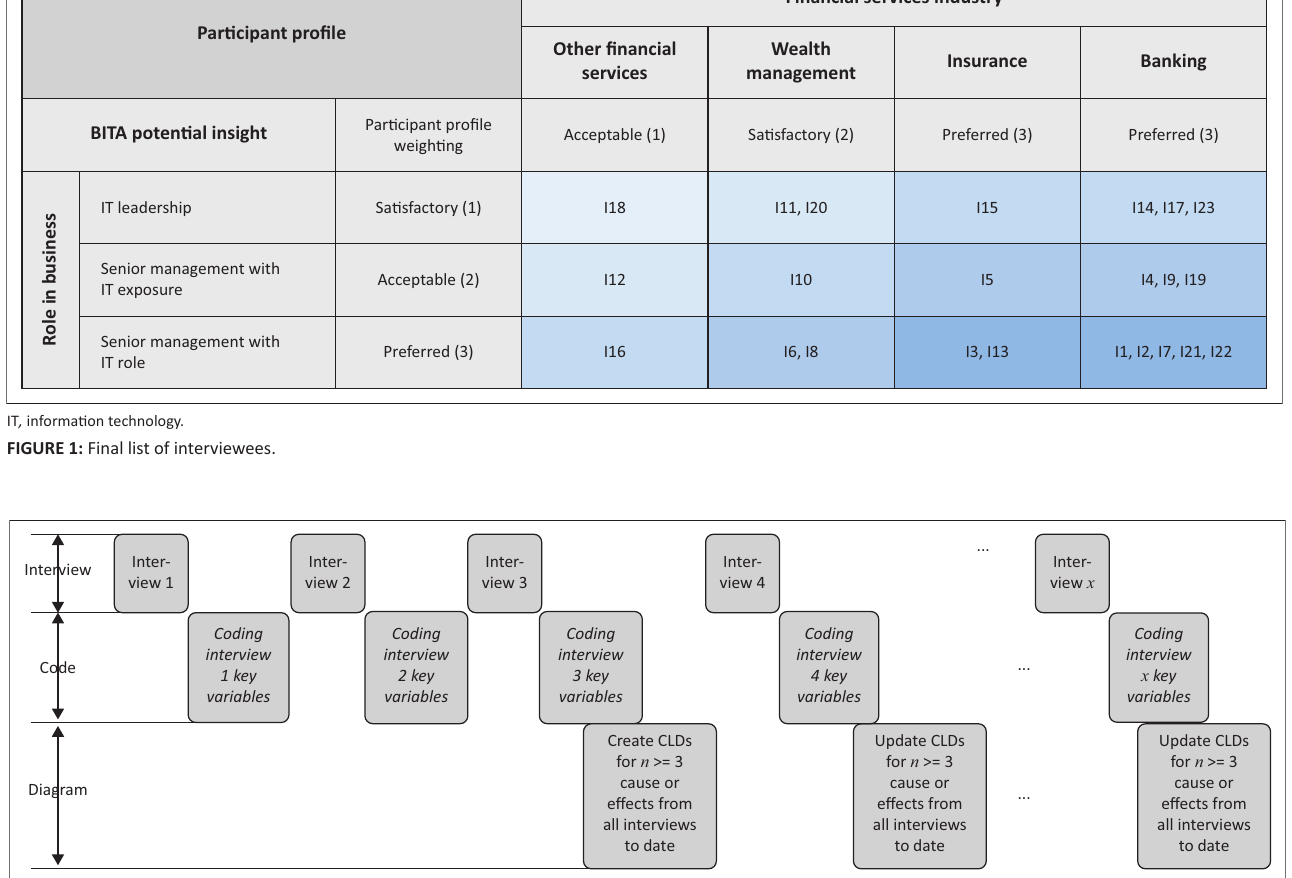
FIGURE 2: Research method for building causal loop diagram from interview data.